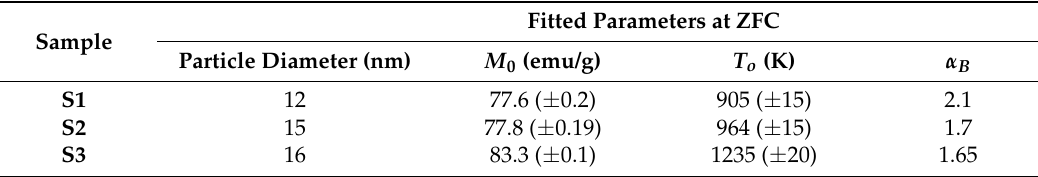
Table 2. The fitted magnetic parameters to the modified Bloch’s law.